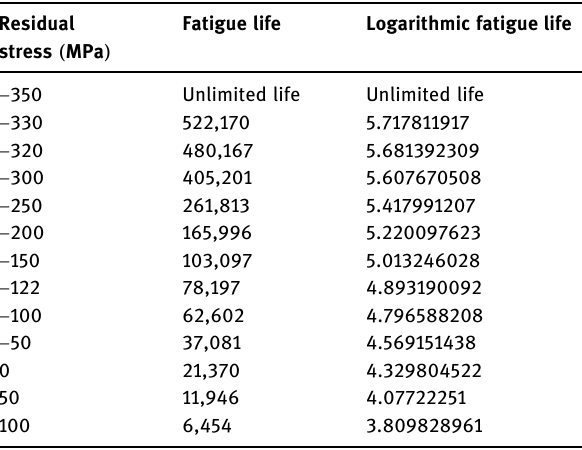
Table 9: The fatigue life under di ff erent residual stress Residual Fatigue life stress ( MPa )